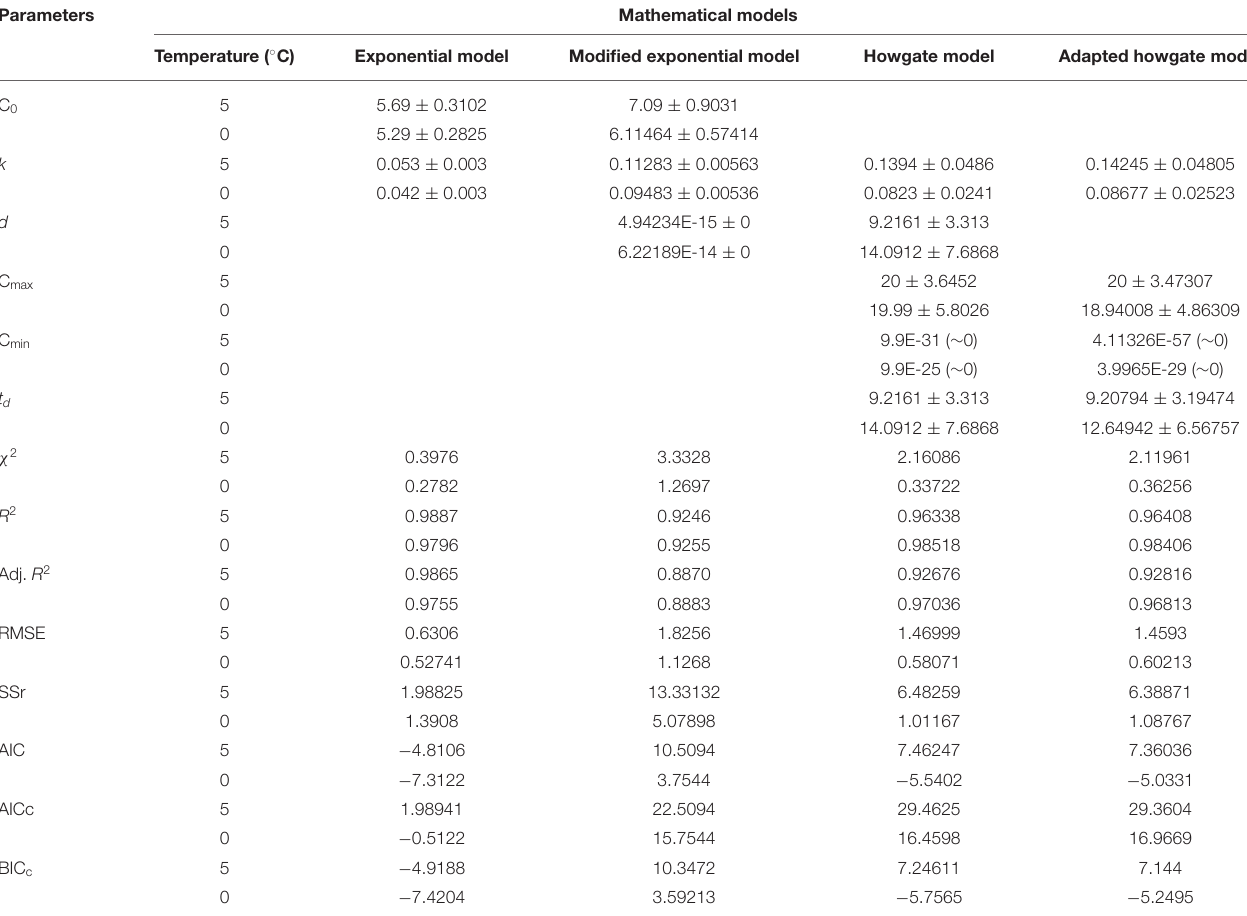
TABLE 2 | Model and statistical parameters of different empirical models for TVB-N formation in stored Rohu